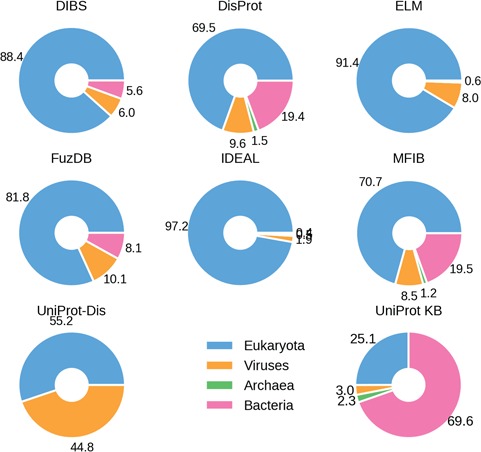
Percentage ID taxa of origin. Eukaryotes are shown in blue, viruses in pink and prokaryotes in orange. Archaea (in green) are mostly absent.